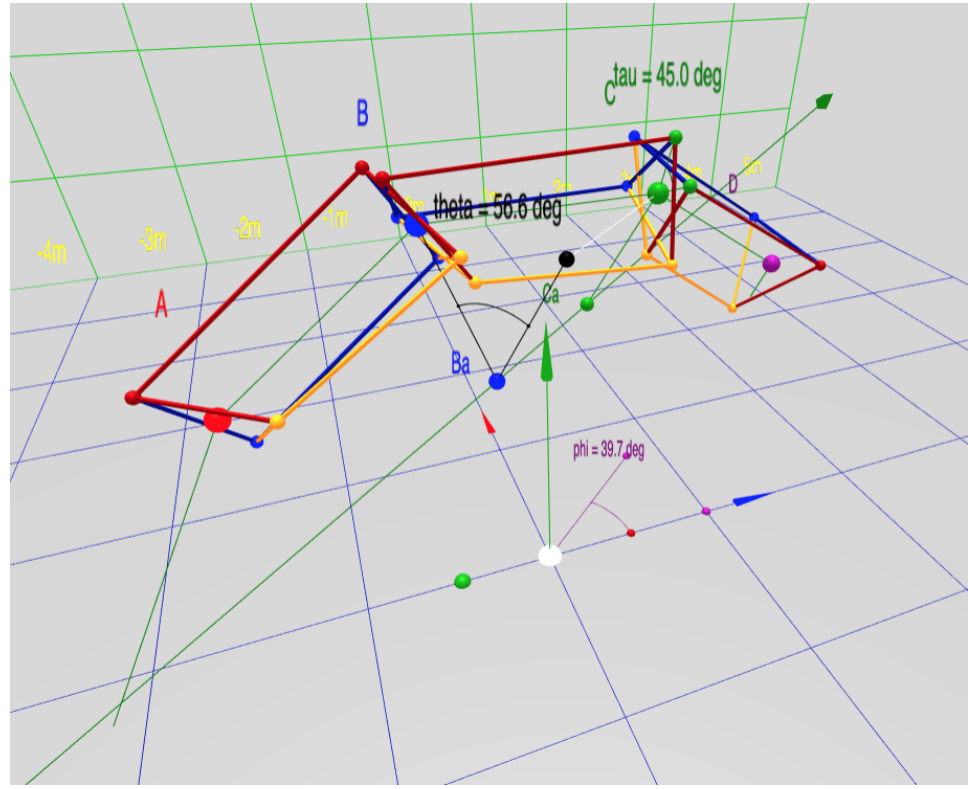
Figure 3. Naming of